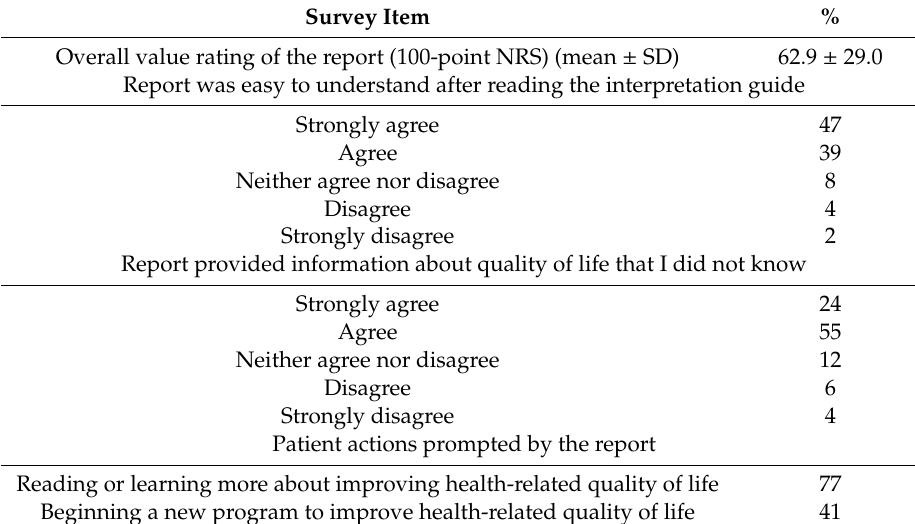
Table 2. Responses to survey on value and utility of the eHealth intervention ( N = 51)